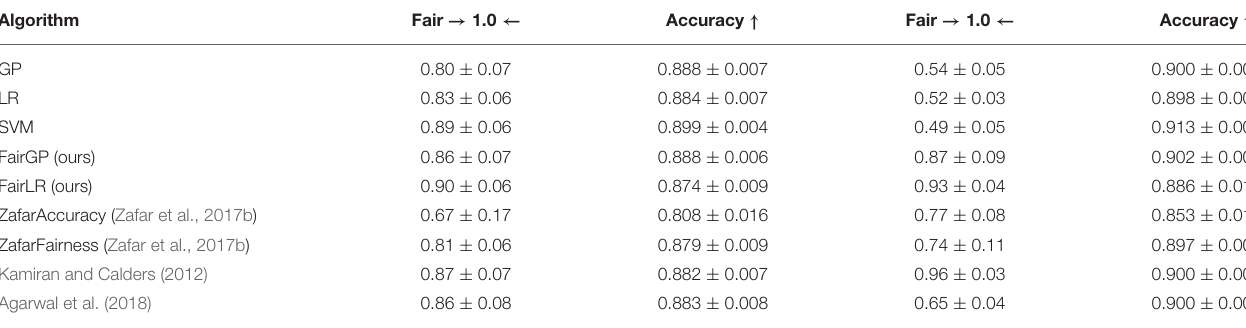
TABLE 1 | Accuracy and fairness (with respect to demographic parity ) for various methods on the balanced test set of the Adult dataset. Algorithm